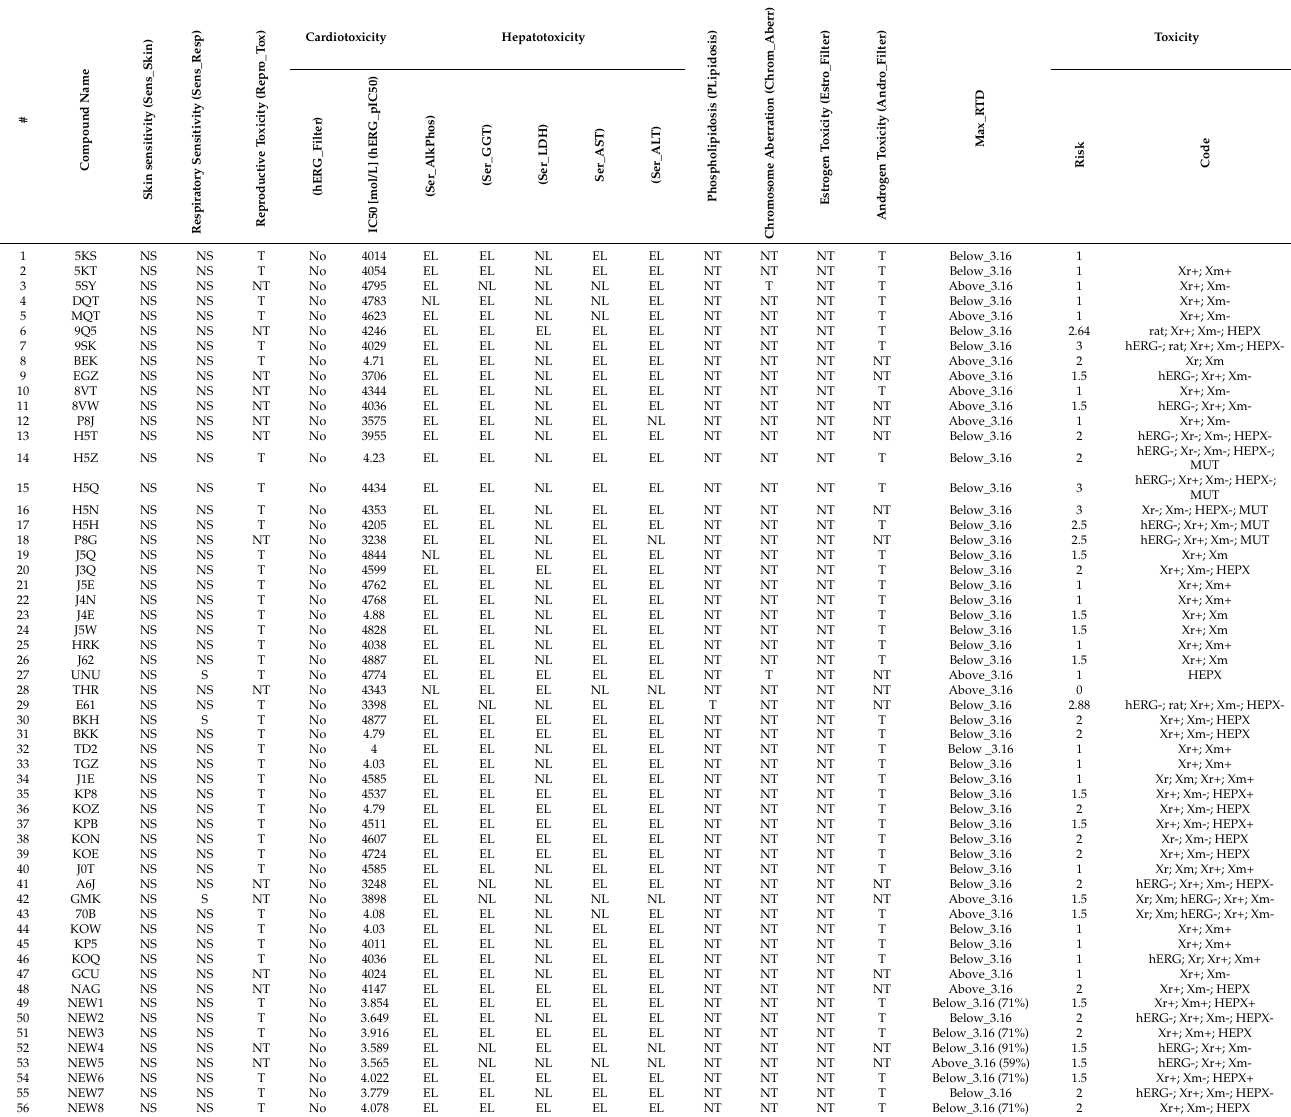
Table 5. Predicted toxicities and toxicity risk for 56 compounds performed by ADMET Predictor software. ADMET Predictor identifier of each toxicity is mentioned in the parenthesis. In particular, Tox_hERG_Filter is a qualitative estimation of the affinity to the hERG potassium channel in human and Tox_hERG is the affinity to the hERG potassium channel in human expressed as pIC50 in mol/L. Compounds with an IC50 less than or equal to 10 µ mol/L were labelled Toxic (T), while those greater than 10 µ mol/L are considered (NT). Human liver adverse effect (the likelihood of causing elevation in the levels of AlkPhos, GGT, LDH, AST and ALT enzymes) is also summarised in hepatotoxicity section and colour-coded as EL (Elevated), NL (Normal). Other toxicity assessments are mentioned in Skin sensitivity, Respiratory sensitivity, Reproductive toxicity, Phospholipidosis, Chromosome aberration, Estrogen and AndrogenToxicity and Max_RTD (Maximum Recommended Therapeutic Dose). The abbreviations used are Nonsensitive (NS), Sensitive (S), EL (Elevated), NL (Normal), T (Toxic) and NT (Nontoxic). Toxicity risk (possible range 0–7) is the risk connected with predicted toxicity problems a compound might have. Toxicity risk less than 2 is considered as safe. Check rules and abbreviations for TOX_Risk and ToX_Code in Section 2.6 for the codes. MV stands for MISSING_VALUE in the ADMET Predictor and colour-coded in